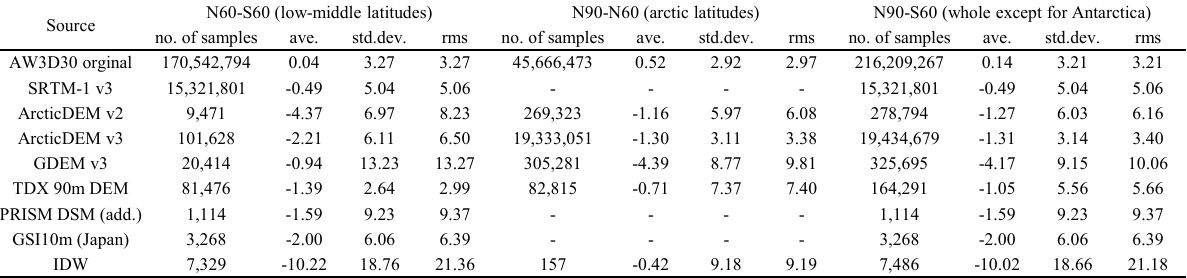
Table 5. Statistics of height errors from ICESat GLA14 in AW3D30 void-filled ver. 3.1 (in meters).